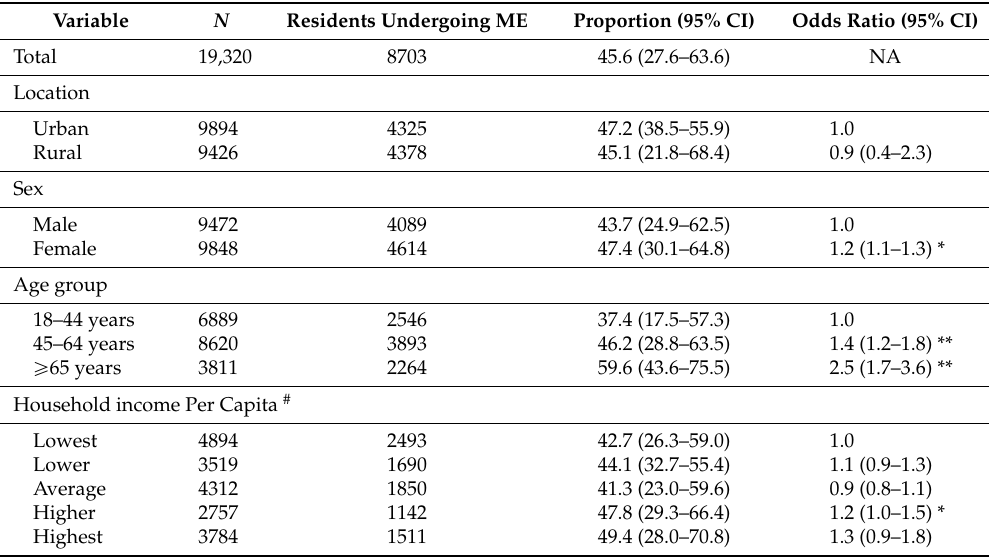
Table 1. Proportion of residents undergoing a medical examination (ME) in the prior 12 months (Hunan of China, 2013).